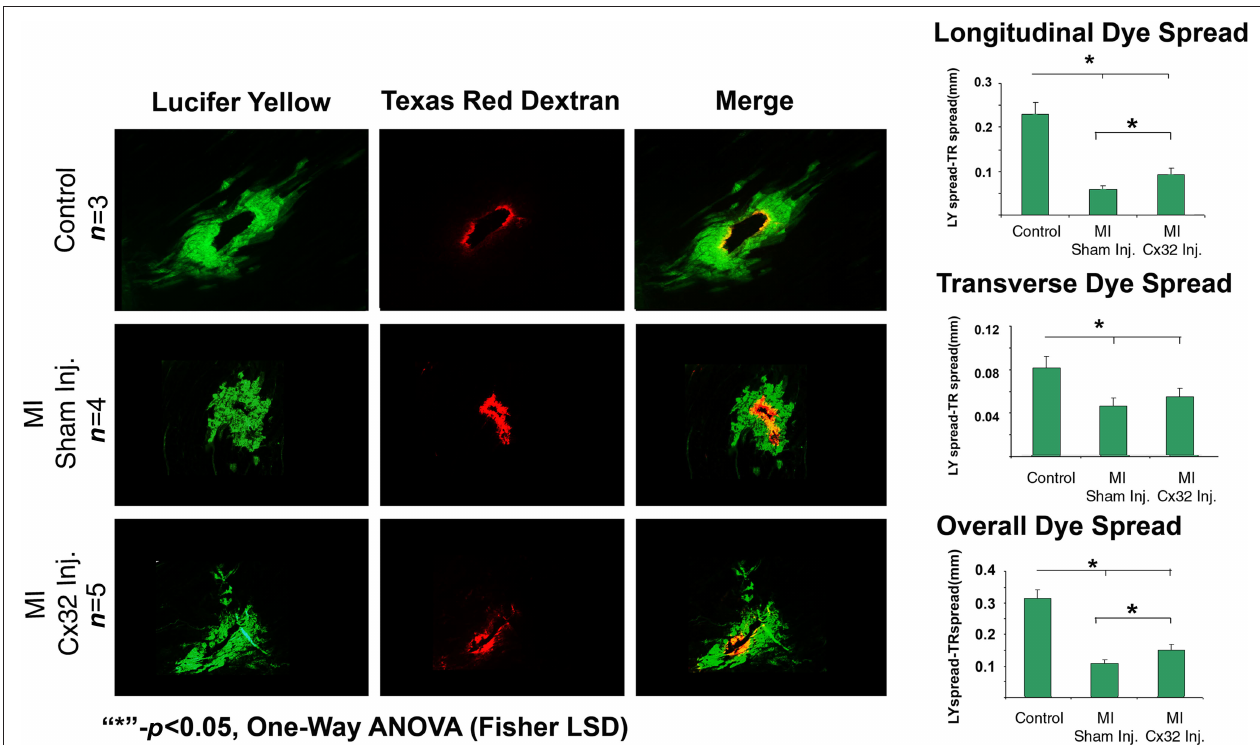
also contain RD indicating a total loss of gap junctional coupling. In contrast, the Cx32inj hearts still exhibit high levels of coupling even after coronary occlusion (MI Cx32 Inj). These data show that addition of Cx32 to the heart rescues the loss of coupling phenotype observed following coronary occlusion in wild-type